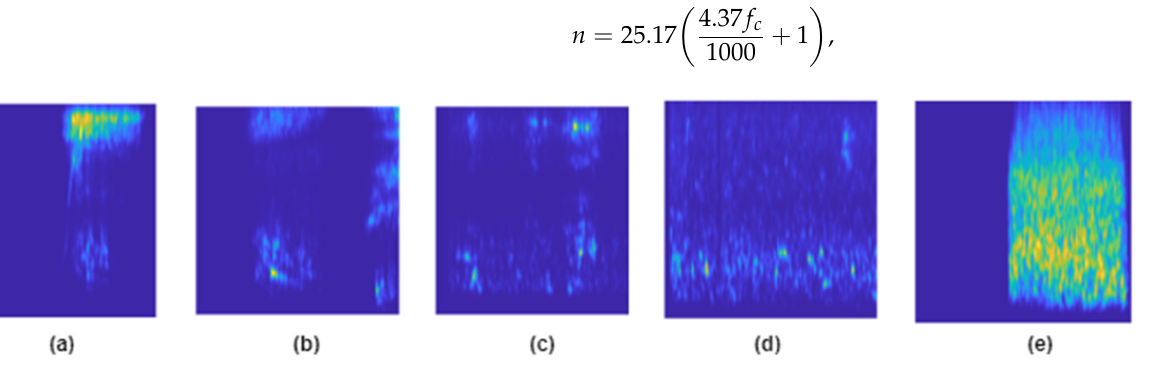
Figure 4. Samples of GFCC images generated from the audio files in each class ( a ) Positive Asymptotic; ( b ) Positive mild; ( c ) Positive Moderate; ( d ) Recovered full ( e )